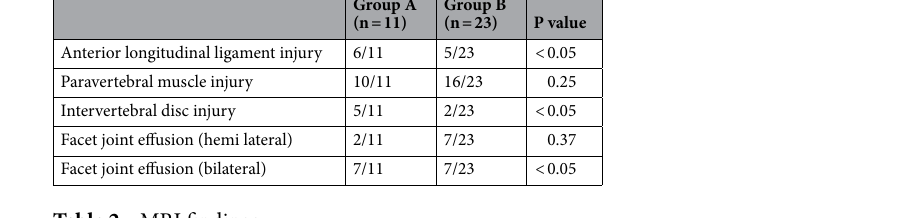
Table 2. MRI findings.